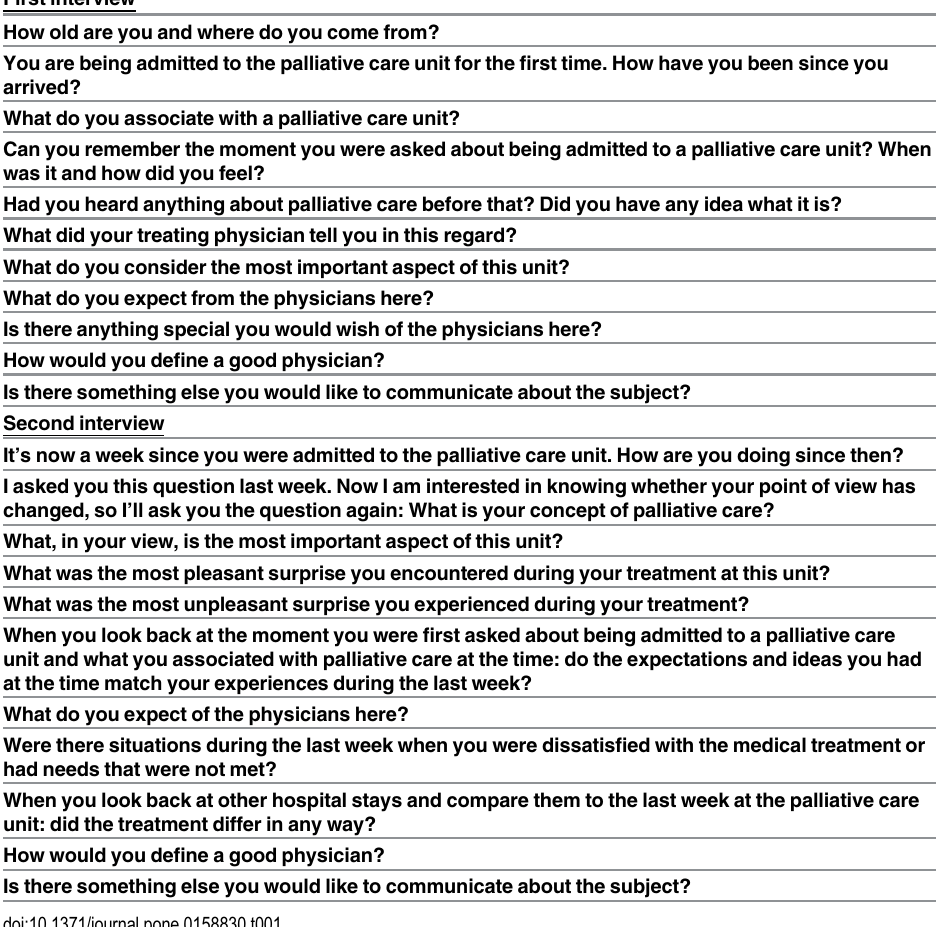
Table 1. Interview Guide for the first and second